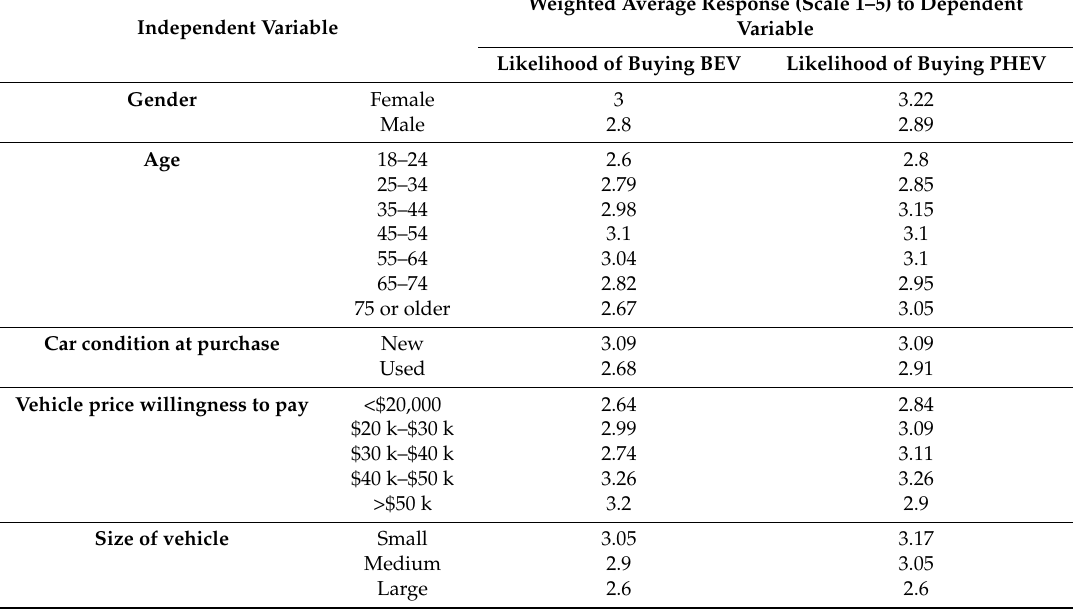
Table 1. Key variables that were more strongly associated with likelihood to buy an EV by Australian pro-environmental motorists from Questionnaire 1 ( n =